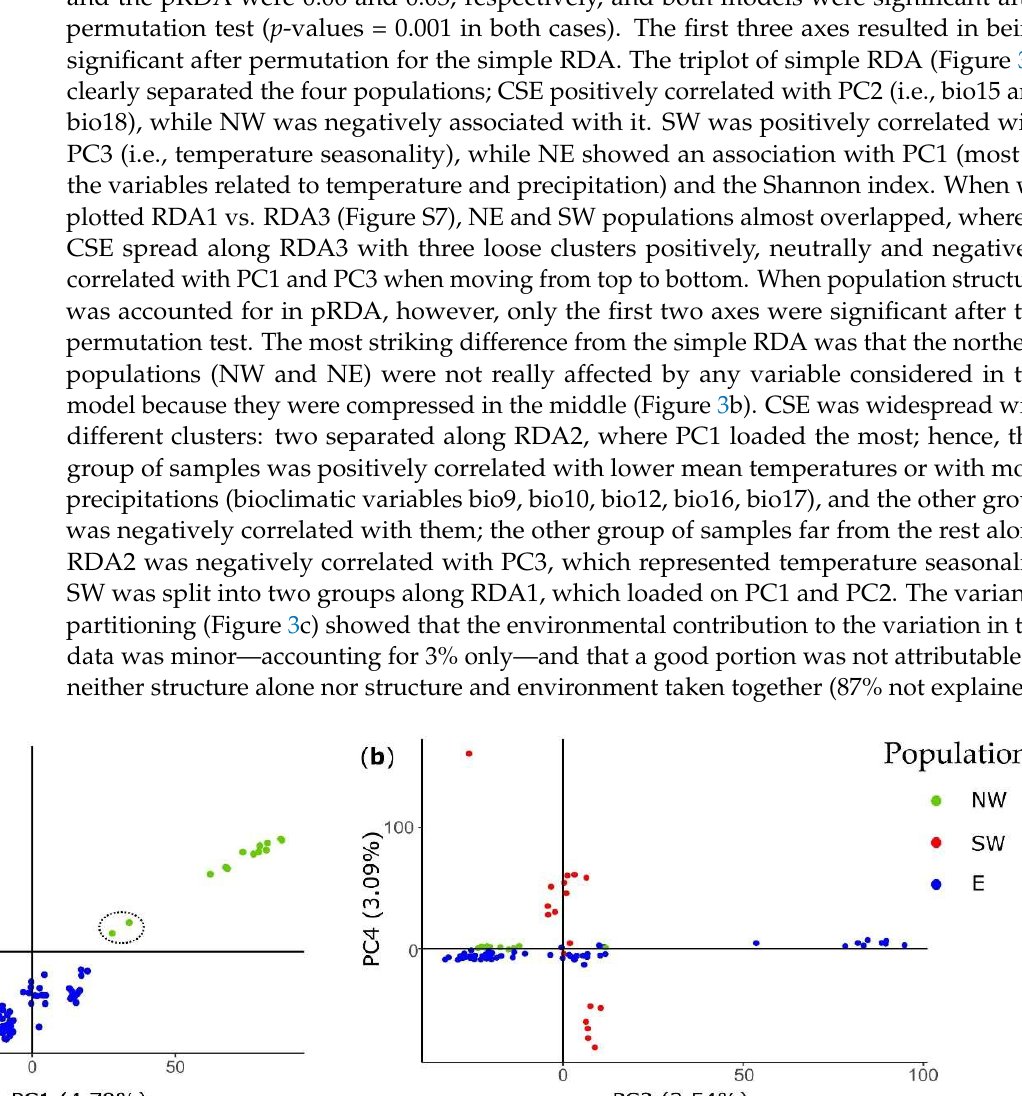
variance in the data). According to the loading plots for the first three PCs on the bioclimatic variables alone (Figure S5), most of the variables loaded on PC1. The two bioclimatic variables referred to variation in temperature and precipitation (bio4 and bio15) loaded more on PC3 and PC2, respectively. Pcadapt found 113, LFMM 134, and RDA 1289 SNP outliers (Figure 3), distributed across all chromosomes. Forty-eight outliers in pcadapt (42%) were associated to PC4— the axis describing genetic variation within SW—while a similar number of outliers were found to be associated to PC1 (25) or PC2 (30), that separated NW from SW and western from eastern sides of the island, respectively. In LFMM, the environmental descriptor that was associated with most outliers was PC2, primarily influenced by precipitation seasonality (bio15) and precipitation of the warmest quarter (bio18) (Figure S5); these variables follow a west–east cline of variation (see Figure S6). The adjusted R 2 for the RDA and the pRDA were 0.06 and 0.03, respectively, and both models were significant after permutation test ( p -values = 0.001 in both cases). The first three axes resulted in being significant after permutation for the simple RDA. The triplot of simple RDA (Figure 3a) clearly separated the four populations; CSE positively correlated with PC2 (i.e., bio15 and bio18), while NW was negatively associated with it. SW was positively correlated with PC3 (i.e., temperature seasonality), while NE showed an association with PC1 (most of the variables related to temperature and precipitation) and the Shannon index. When we plotted RDA1 vs. RDA3 (Figure S7), NE and SW populations almost overlapped, whereas